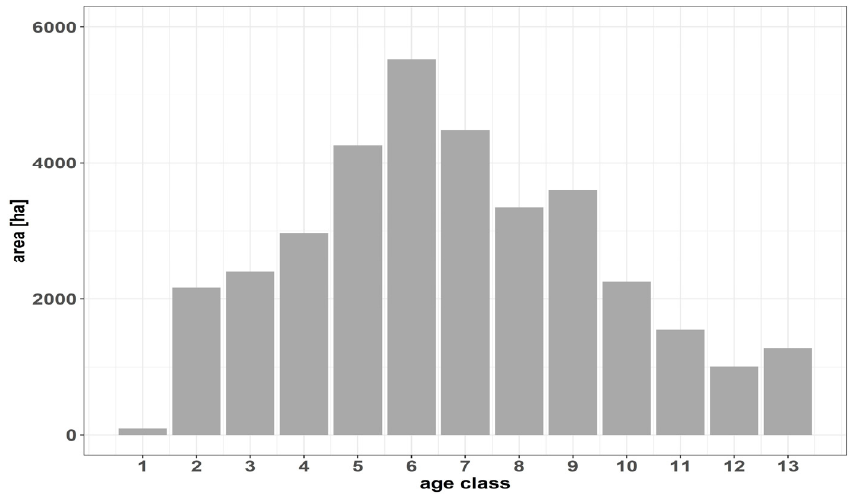
Figure 3. Distribution of the volume classes over the area (ha) used in EFDM.